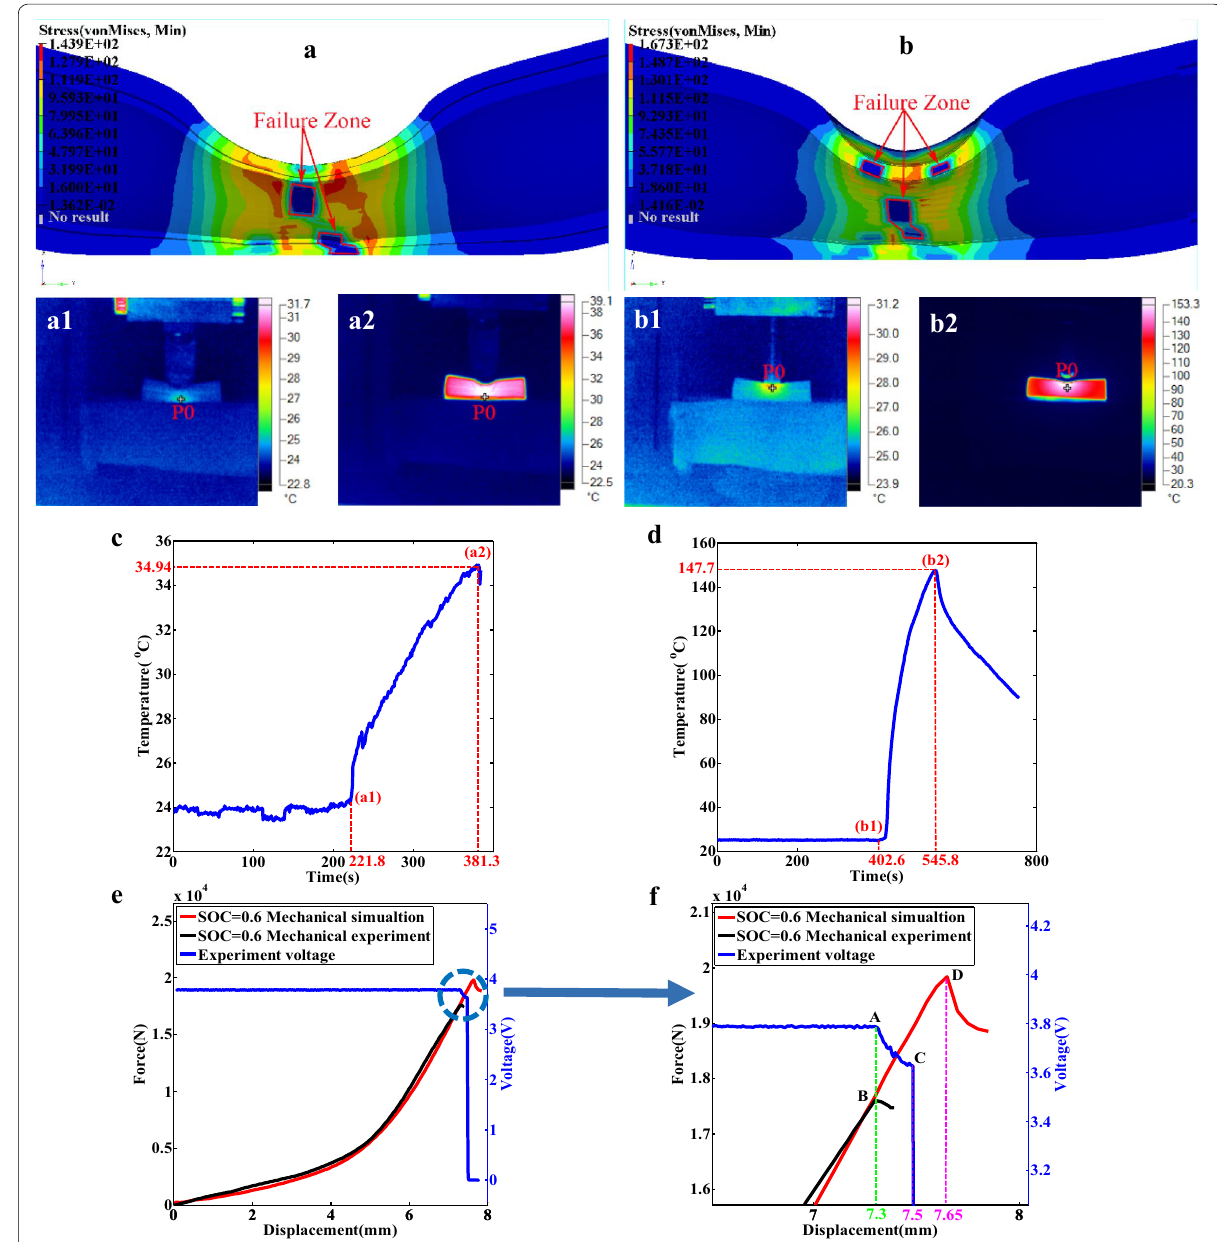
Figure 9 Stress cloud, temperature, and voltage: a Stress cloud under rigid rod test by simulation, b Stress cloud under hemispherical punch test by simulation, a1 Temperature at the start of thermal runaway under rigid rod test, a2 The highest temperature under rigid rod test, b1 Temperature at the start of thermal runaway under hemispherical punch test, b2 The highest temperature under hemispherical punch test, c Temperature under rigid rod test, d Temperature under hemispherical punch test, e Mechanical and electrical experiments, simulation results of rigid rod test under SOC 0.6, f Local magnification of Figure =